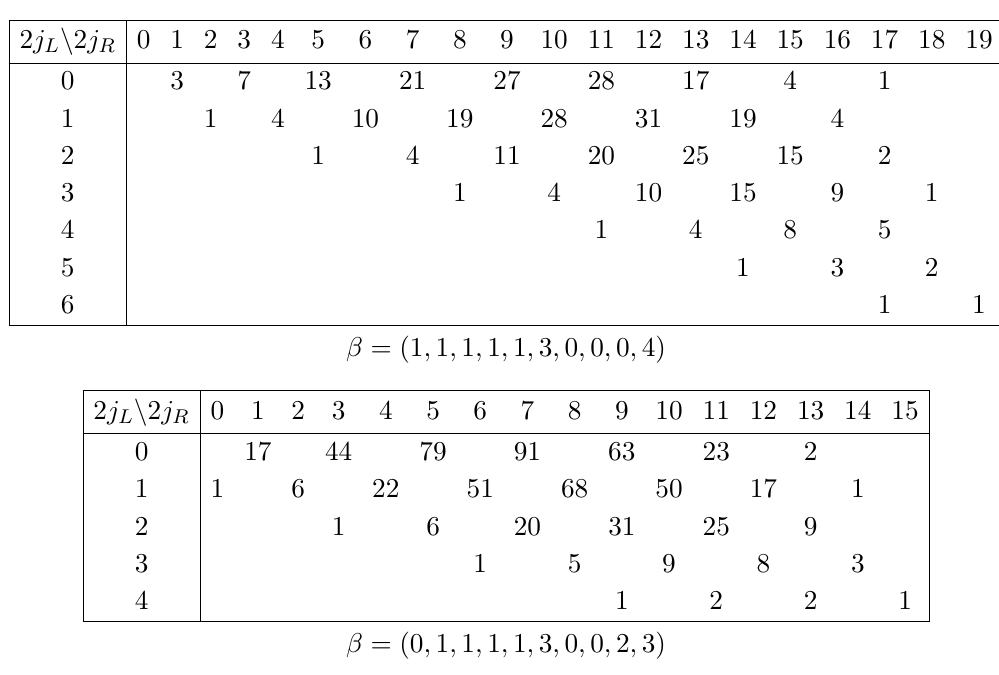
Table 31 . Re(cid:12)ned BPS invariants for selected degrees of 6d E 8 minimal